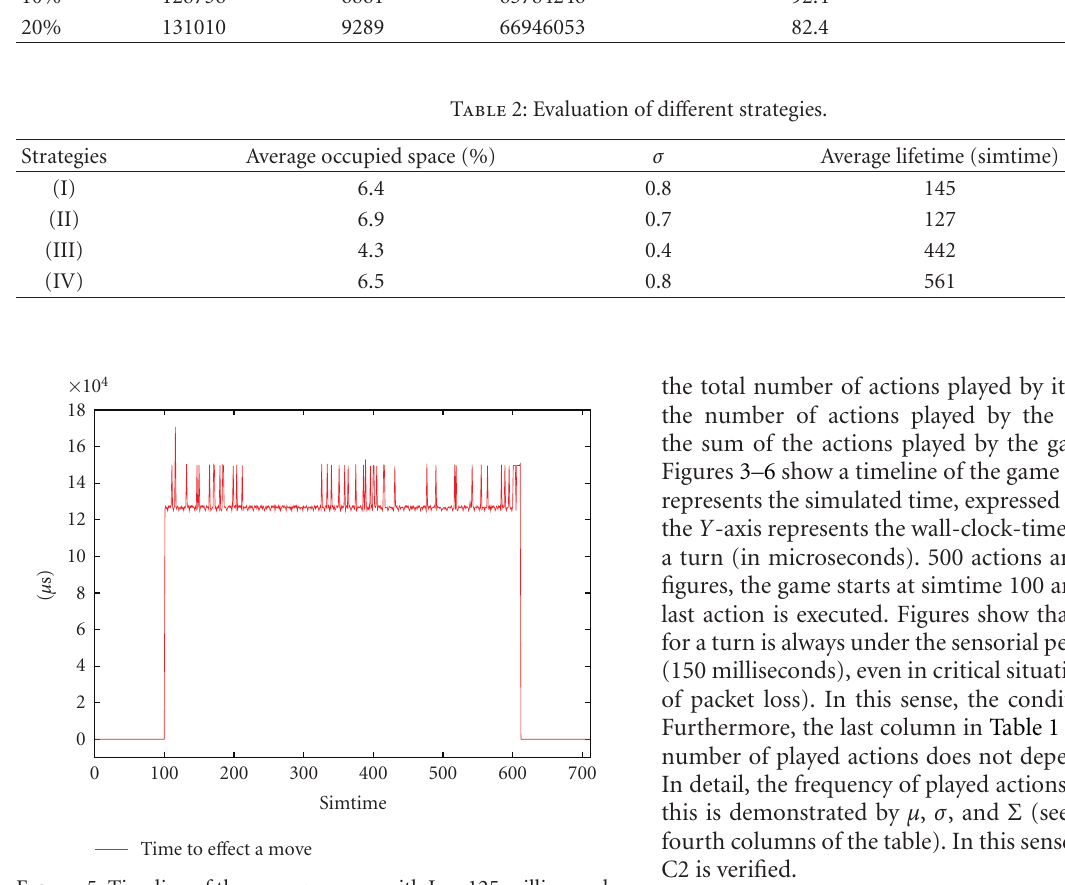
Figure 5: Timeline of the game progress with L = 125 milliseconds and PL = 10%.